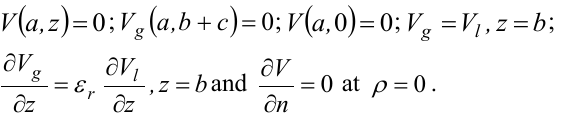
Table 3. Parameters for